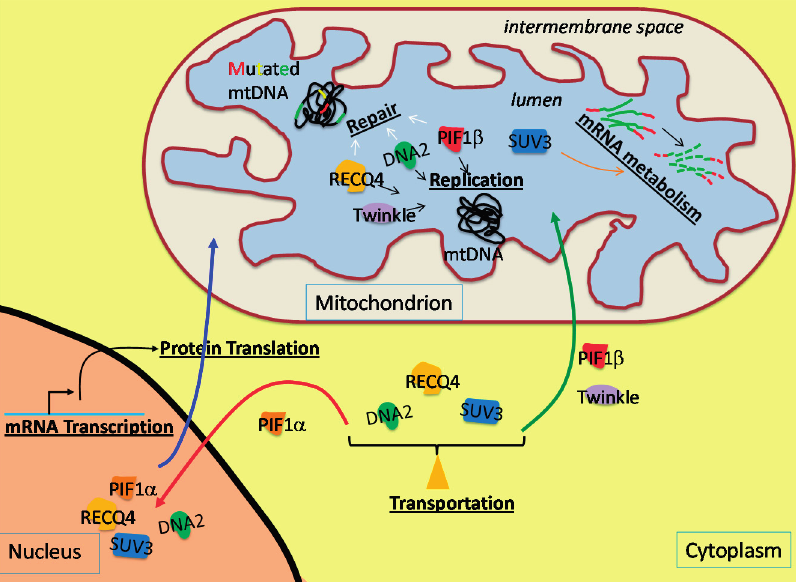
Figure 1. Schematic diagram of the production and the cellular localization of the DNA helicases (Twinkle, purple; RecQ-like helicase 4 (RECQ4), yellow; DNA replication helicase/nuclease 2 (DNA2), green; petite integration frequency 1 (PIF1), red; suppressor of var1 3-like protein 1 (SUV3), blue) that function in the mitochondrion. These DNA helicases are encoded in the nuclear genome, produced in the cytoplasm and transported into the mitochondrial lumen. With the exception of Twinkle, other DNA helicases, including RECQ4, DNA2, PIF1 and SUV3, are transported into the mitochondrial lumen or nucleus depending on the molecular cue. In the mitochondrion, these helicases participate in DNA replication and repair, as well as mRNA metabolism, in order to maintain mtDNA